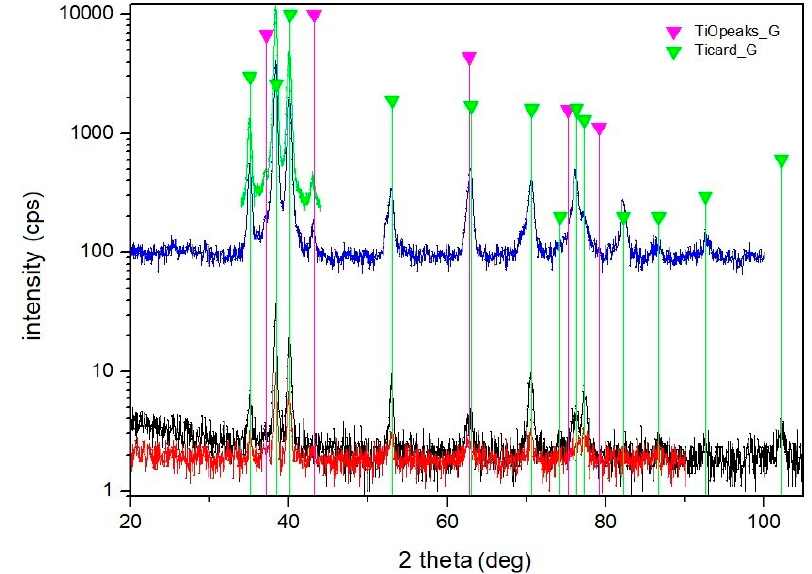
Figure 14. X-ray diffraction patterns of machined surface E (Brucker D8, incidence angle 10 deg {black colour) and incidence angle 15 deg (red colour); Brucker D8 with rotational anode, incidence angle 6 deg (blue colour) and 12 deg (green colour).